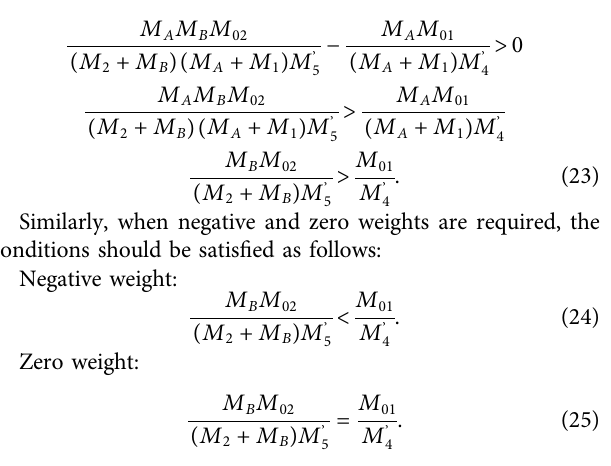
Frontiers in Physics |